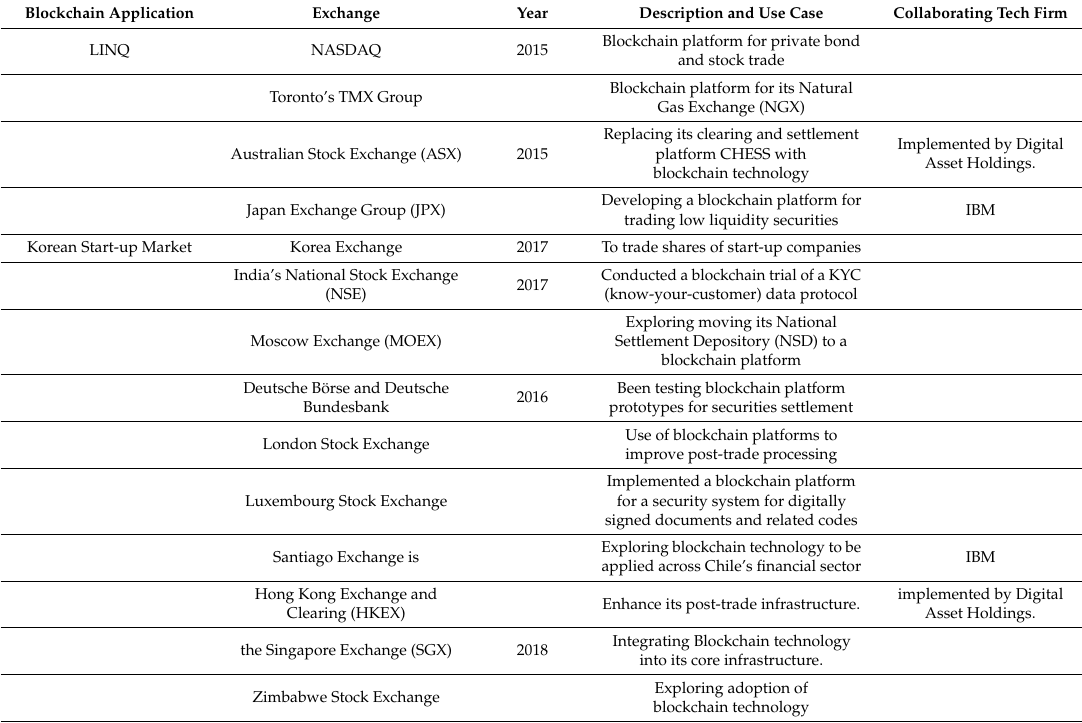
Table 6. Present Blockchain Applications in Corporate Governance.